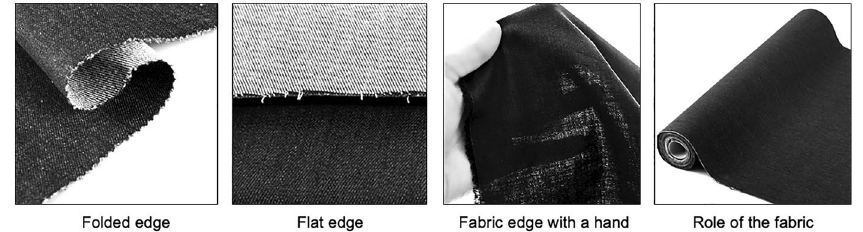
Fig. 2 Various methods of showing the fabric